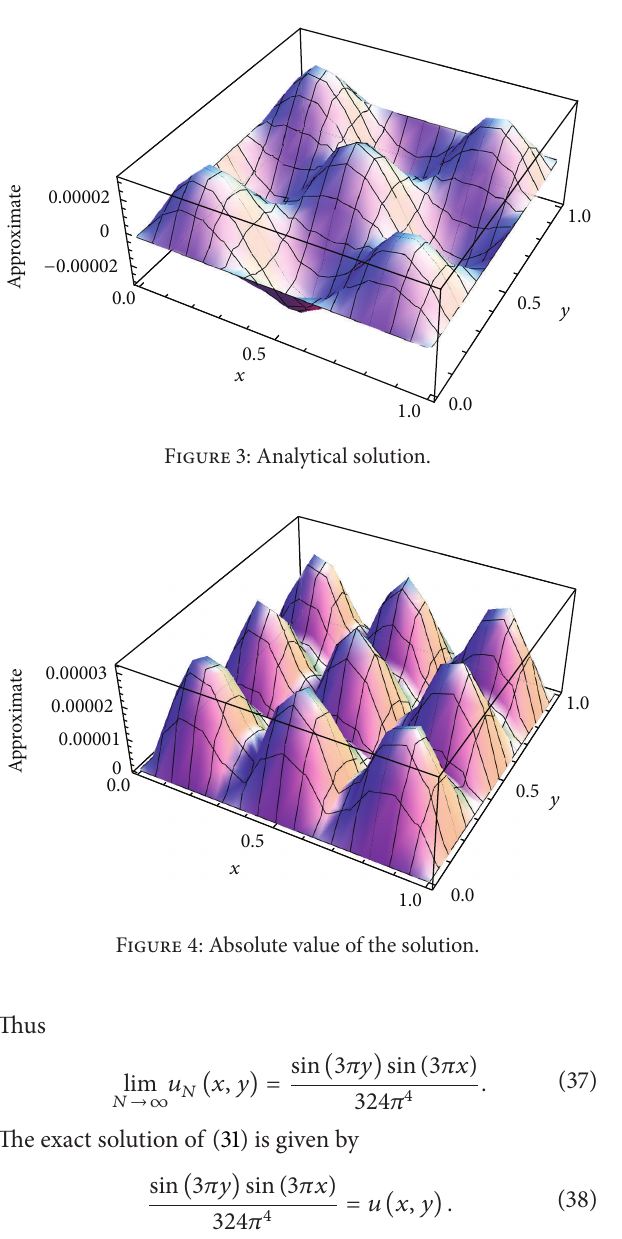
Figure 4: Absolute value of the